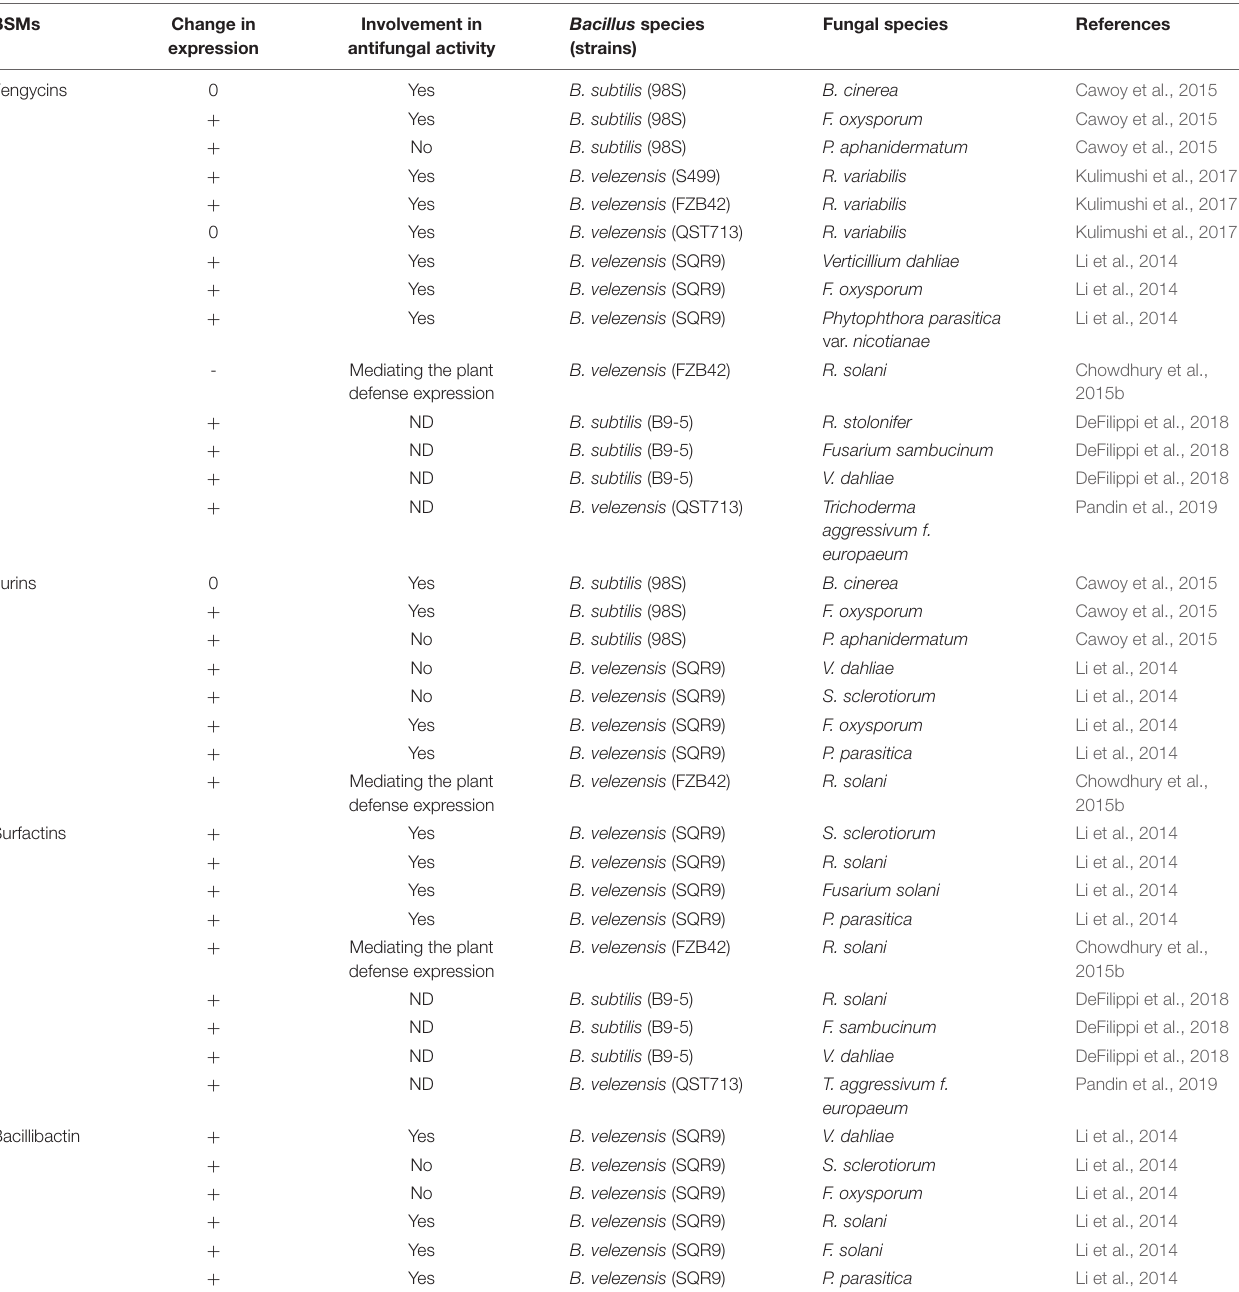
TABLE 1 | Change in expression and bioactivity of BSMs produced by members of B. subtilis group, upon interaction with fungal species.